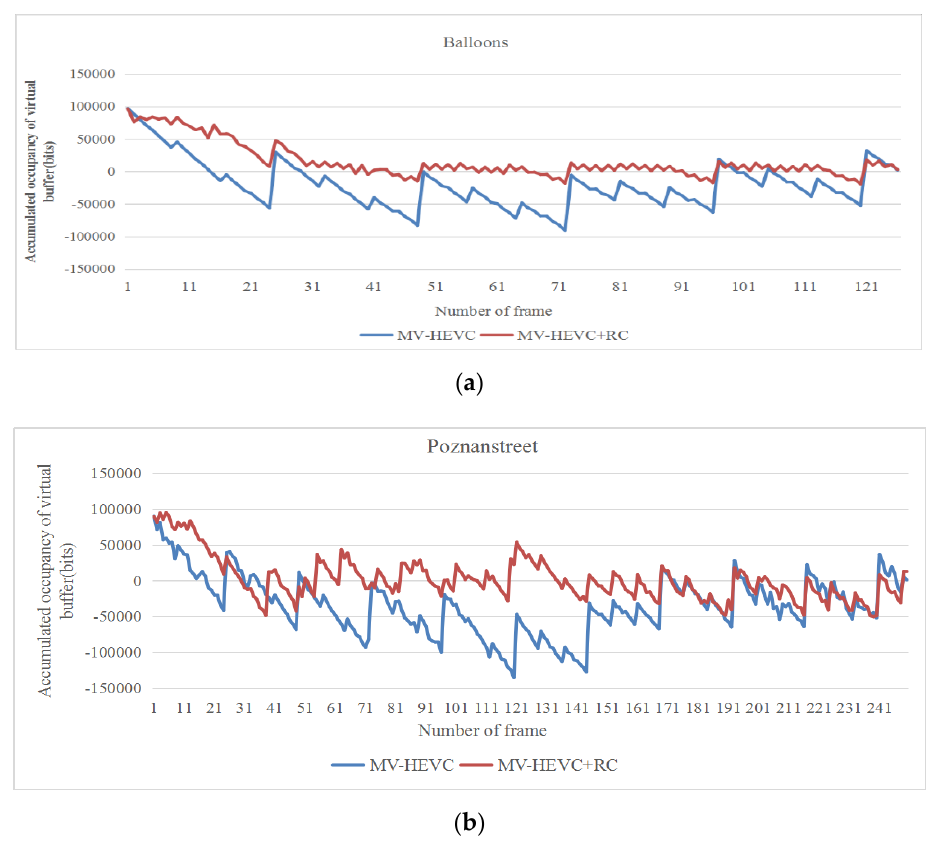
Figure 4. Experimental results of sequences: ( a ) “Balloons”, and ( b ) “Poznanstreet”.